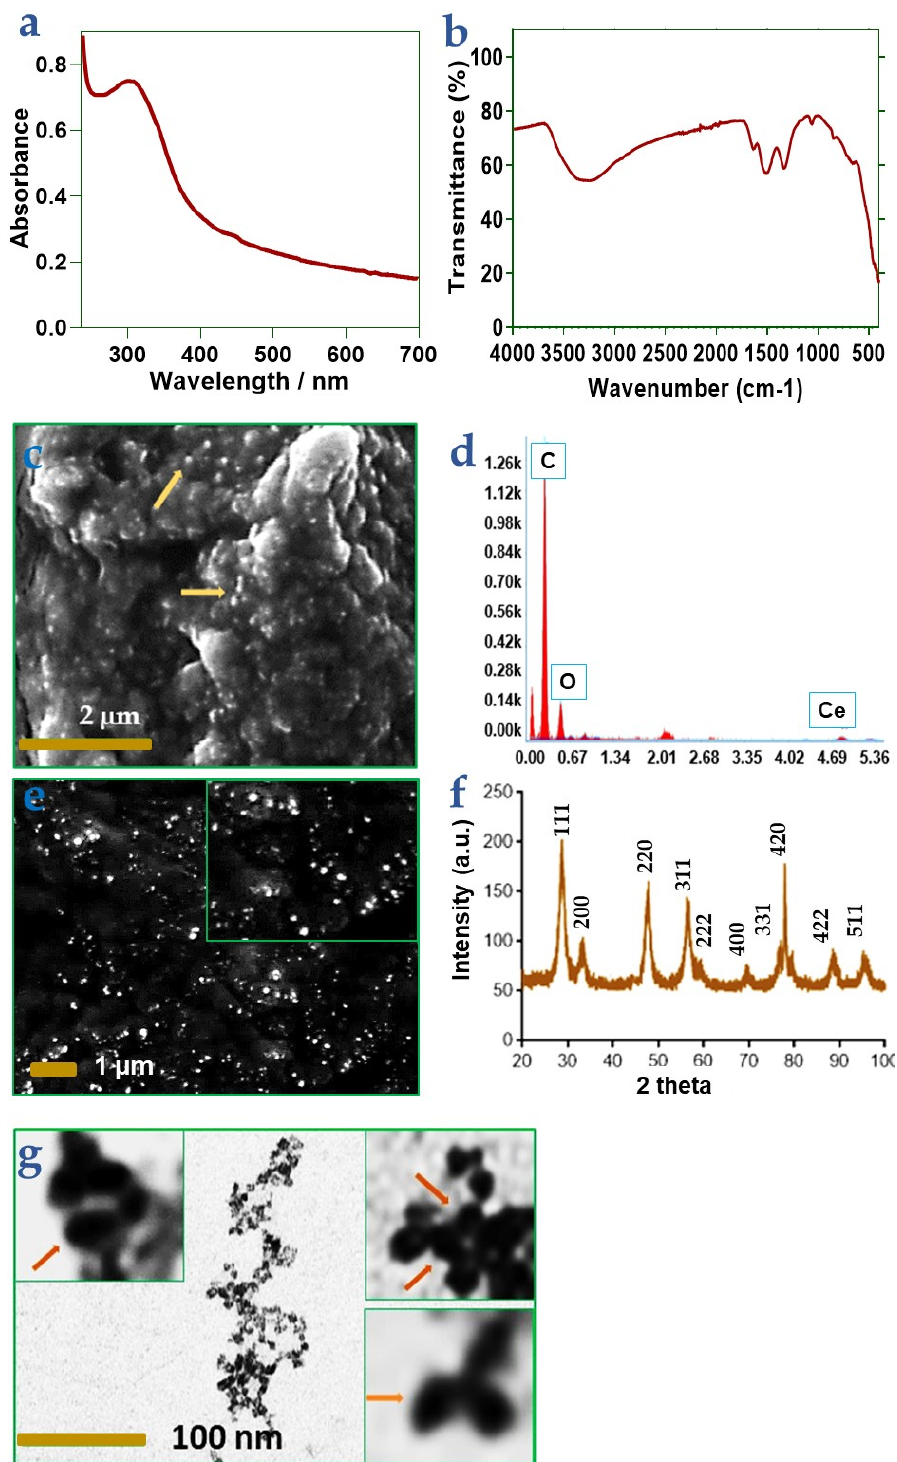
Figure 1. Characterization of nCeO 2 , using ( a ) UV spectra, ( b ) FTIR, ( c ) SEM–powder NPs, ( d ) EDX, ( e ) SEM with NPs suspended in aqueous solution, ( f ) XRD and ( g ) TEM micrograph, where the inserts declare the spherical/ovoid-shaped nCeO 2 .